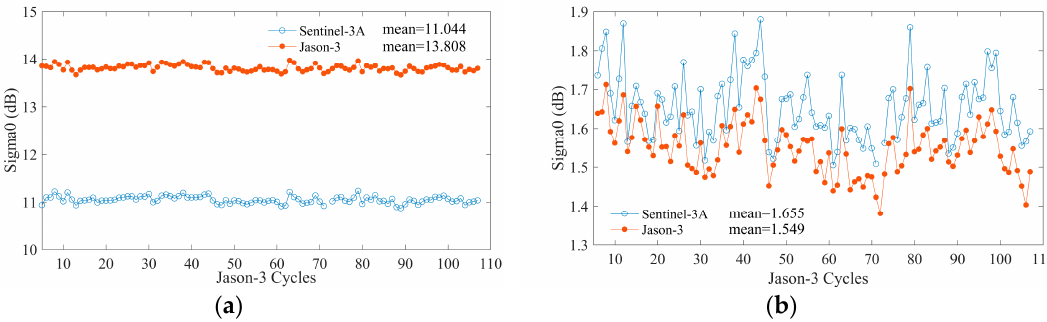
Figure 27. Comparison of cycle by cycle ( a ) means and ( b ) standard deviations of backscattering coefficients between Sentinel-3A and Jason-3 according to Jason-3 repeat cycles.